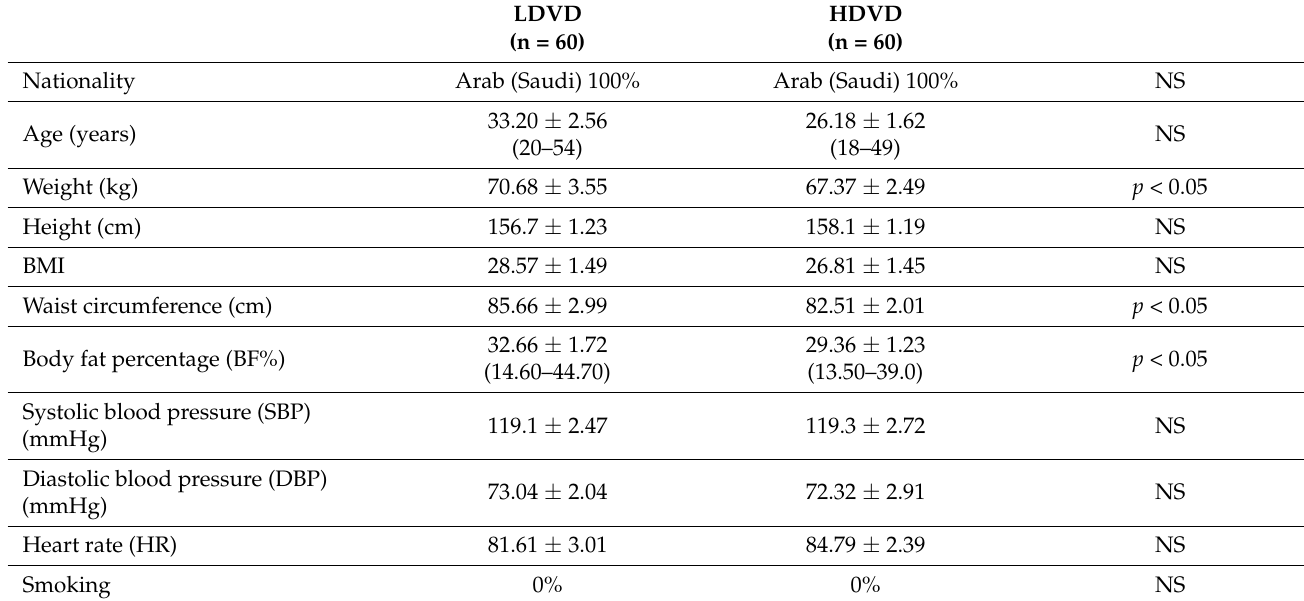
Table 1. Anthropometric and demographic data of the study groups.